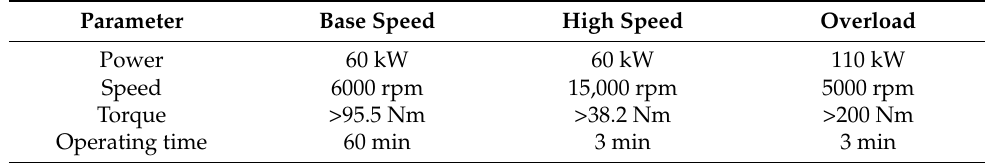
Table 2. Motor three main operating conditions.